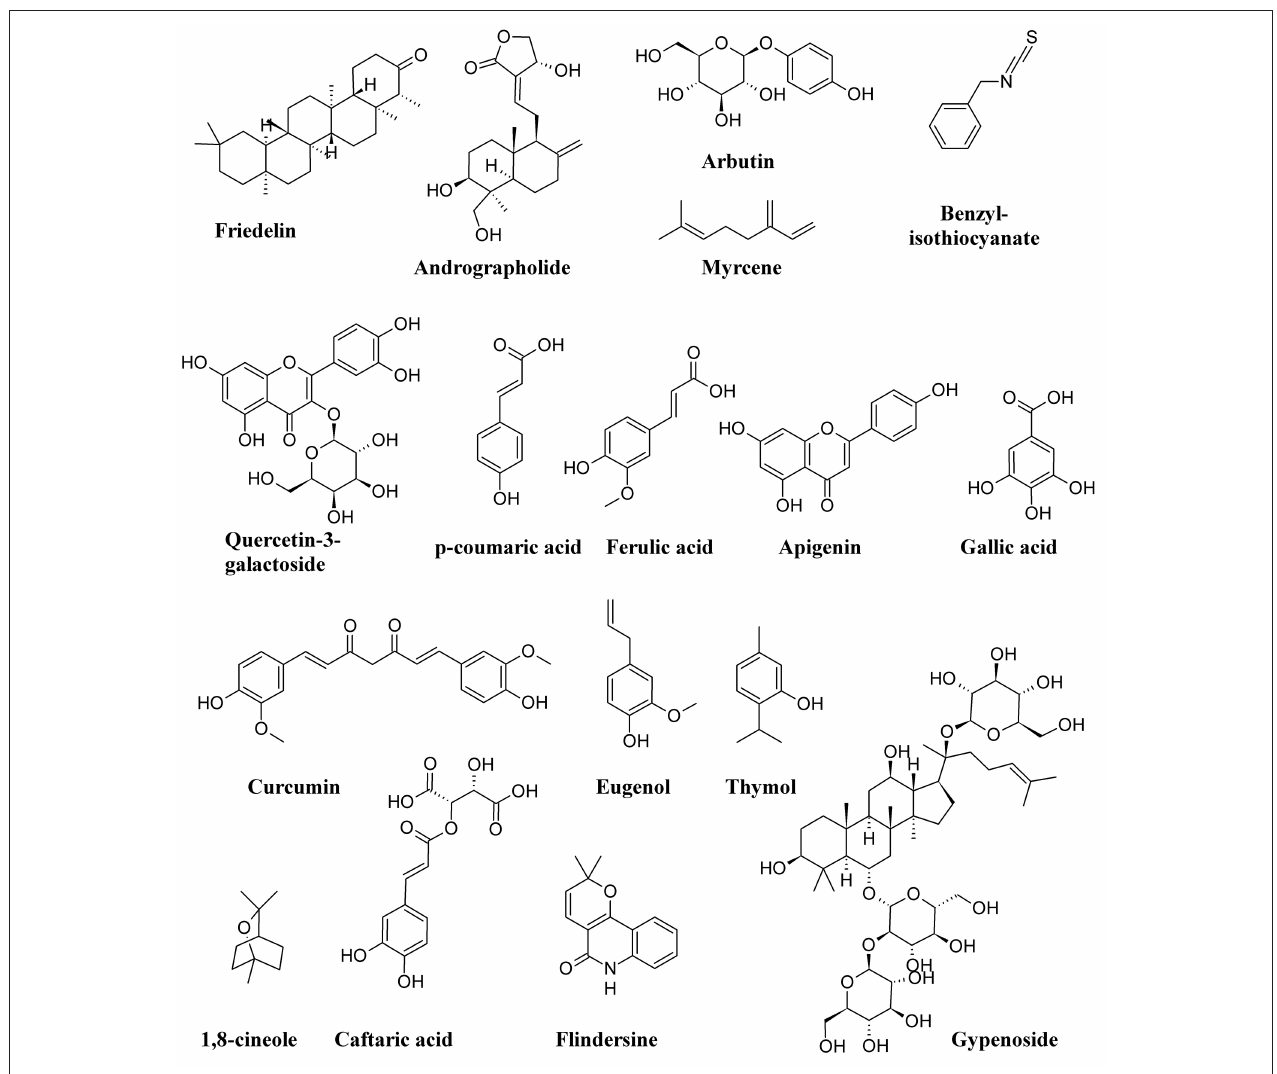
FIGURE 11 | Structure formulae of some representative bioactive compounds isolated from plant extracts exerting antimicrobial activity against UPEC listed in Table 1